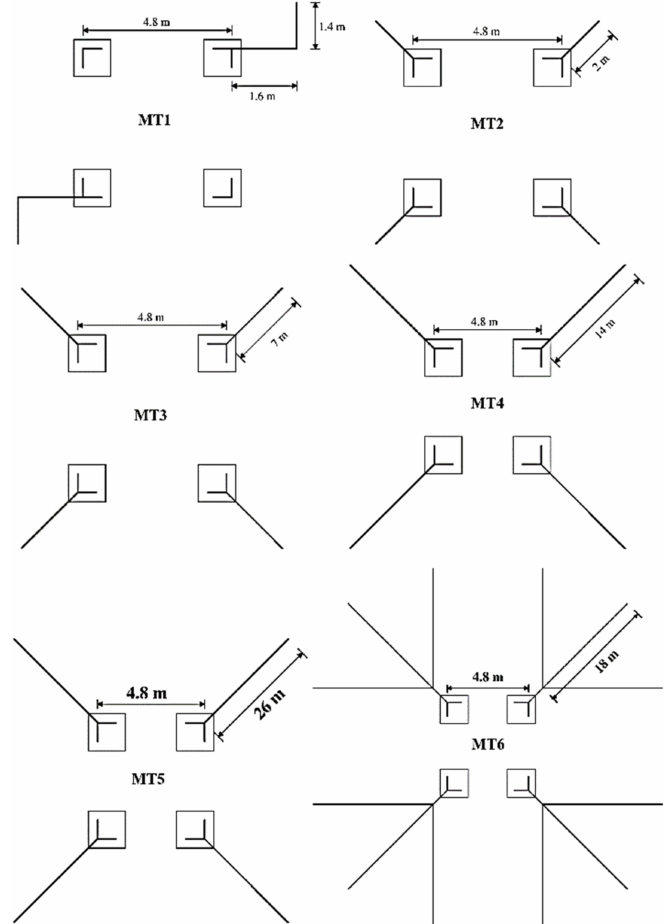
Figure 2. Grounding systems installed in Italian 150 kV OHLs according to Terna unified